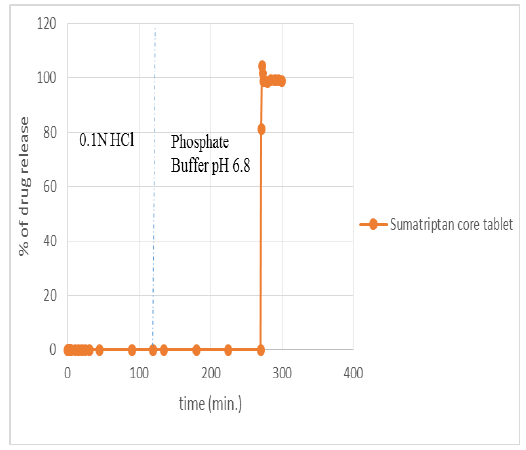
Figure 3. Release profile of sumatriptan